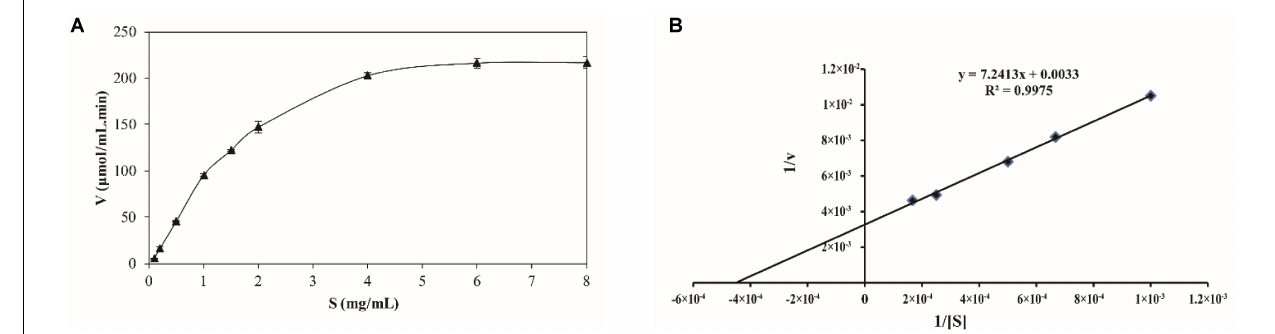
FIGURE 5 | (A) Substrate-velocity curve and (B) Lineweaver–Burk plot of purified BspPel. Values are averages of results from triplicate trials; error bars indicate the SD values.